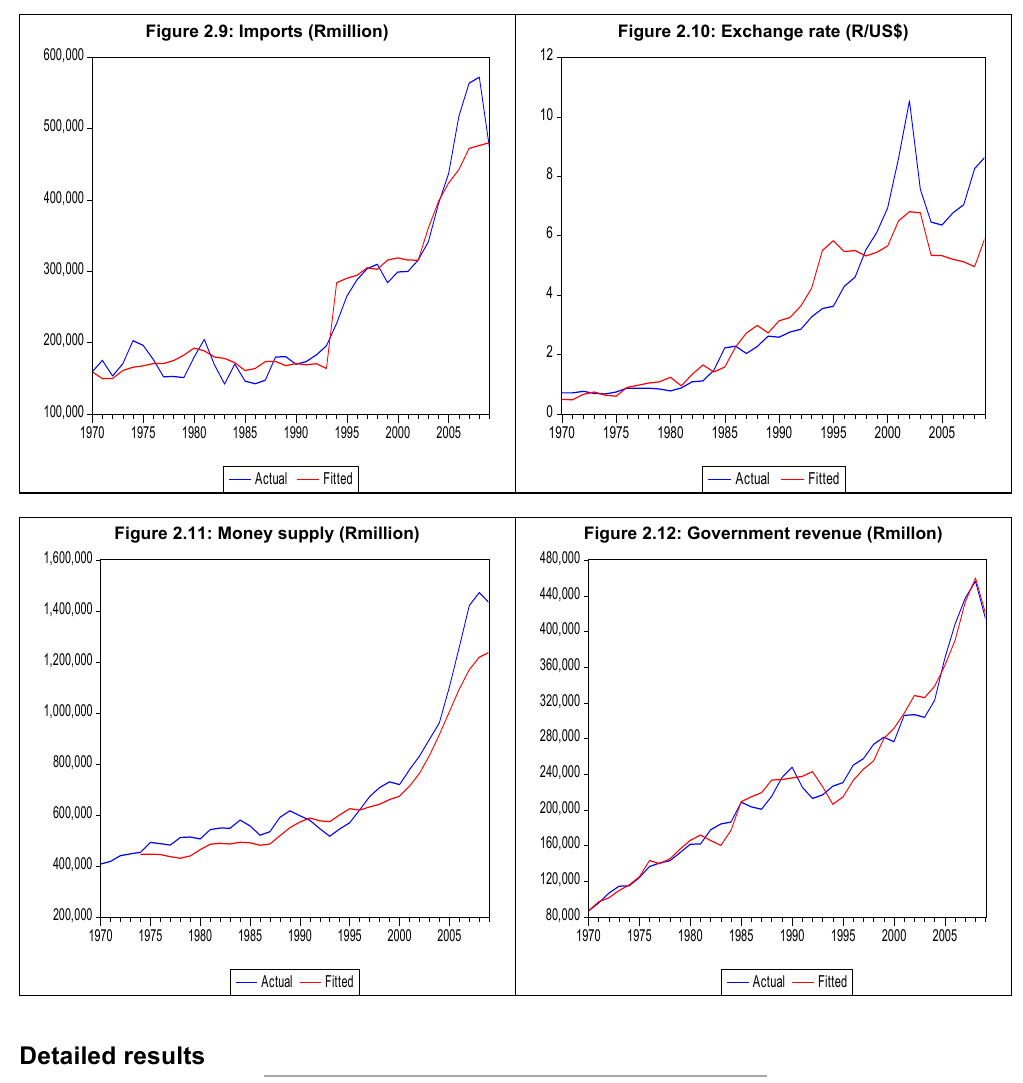
Figure 2.9: Imports (Rmillion) Figure 2.10: Exchange rate (R/US$)